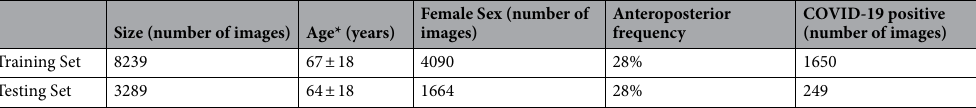
Table 1. Patient characteristics in the training and testing sets. *Reported as average ± standard